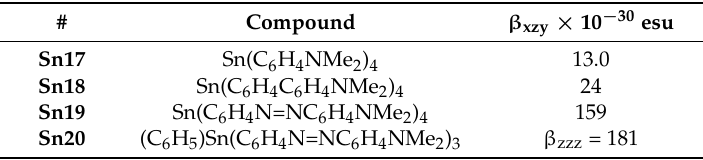
Table 3. Nonlinear optical properties for the tetraorganotin derivatives.